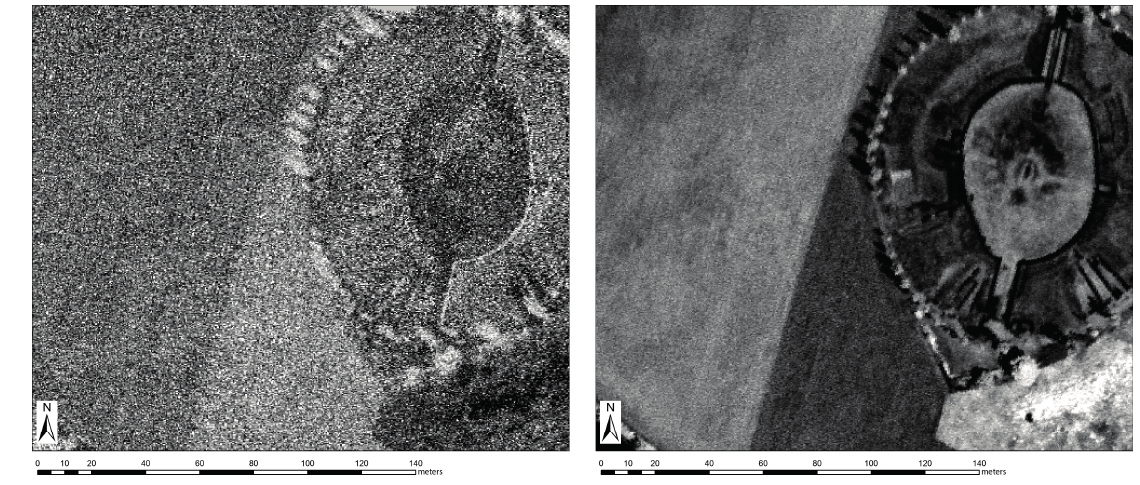
Figure 6. First derivative at ~540 nm (difference between band 25 and 26) calculated from ( left ) the original image and ( right ) the previously smoothed image. For the smoothing in z-direction ( i.e. , along the wavelength dimension) the Whittaker smoother implemented in ARCTIS with λ = 10 was